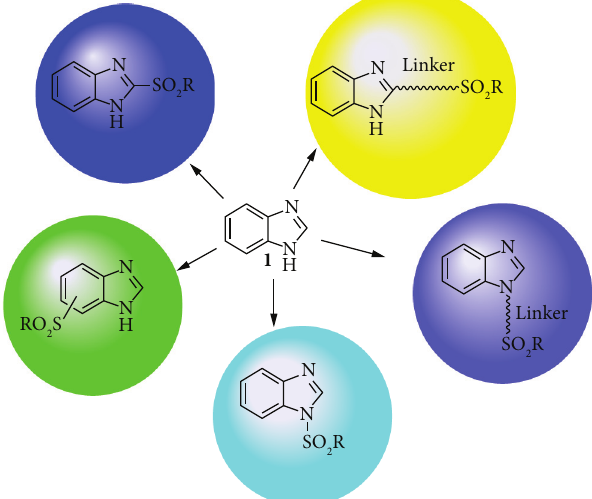
Figure 1:Chemical structure of benzimidazole-sulfonyl